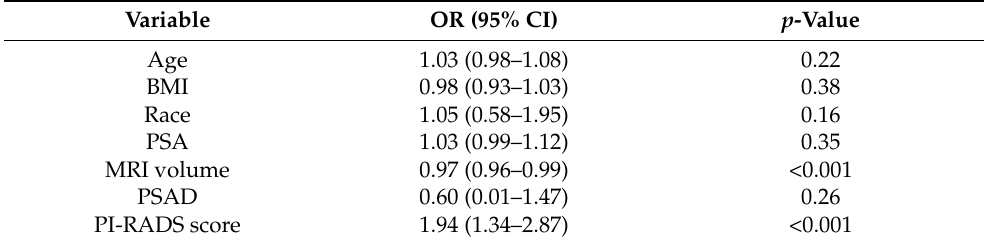
Table 2. Logistical regression of demographic characteristics and likelihood of cancer